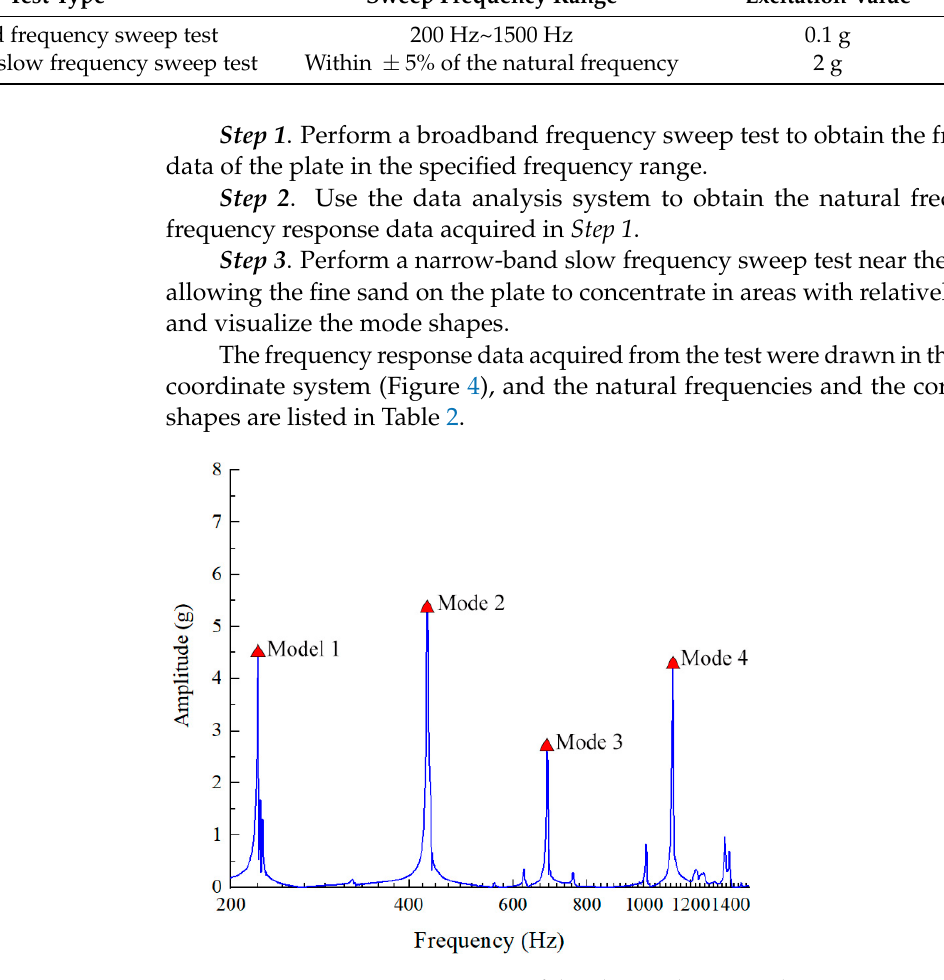
Figure 4. Frequency response curve of the plate under an acceleration excitation of 0.1 g.